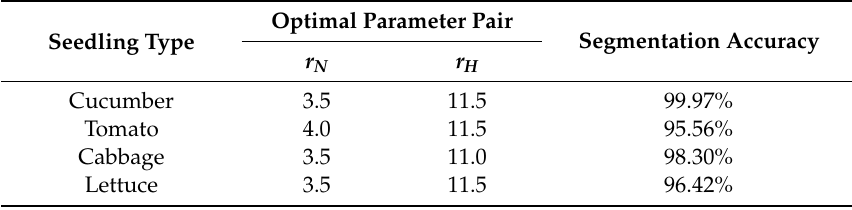
Table 2. Optimal parameter pair for the removal of natural background in di ff erent vegetable